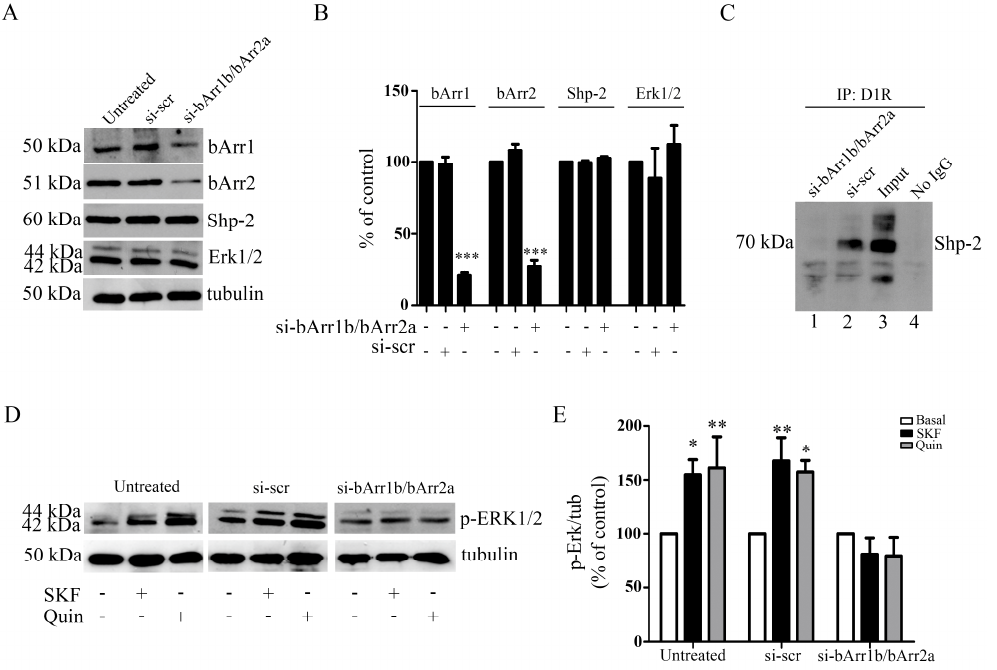
Figure 8 . In mouse primary striatal neurons, beta-arrestin 1/2 are required for activation of Erk1/2 induced with D1R and D3R stimulation. ( A ) Neurons were exposed to a combination of two selective siRNA (si-bArr1b and si-bArr2a; 50nM) and to a non-targeting scrambled sequence (si-scr) for 120 h and analyzed for beta-arrestin1 (bArr1), beta-arrestin2 (bArr2), Shp-2 and total Erk1/2 levels by WB; a representative WB is shown; ( B ) Densitometric analysis of blots (n = 3) with specific signals normalized to the corresponding tubulin levels; bars represent the mean ± S.E.M *** p < 0.001 versus untreated cells. ( C ) Representative blot of co-immunoprecipitation experiments (IP; n = 3) of D1R and Shp-2 using the anti-D1R antibody in striatal neurons (60 ug for each condition), untreated (lane 3) or treated with si-bArr1b/si-bArr2a (lane 1) or si-scr (lane 2) (both at 50 nM; 120 h); omission of